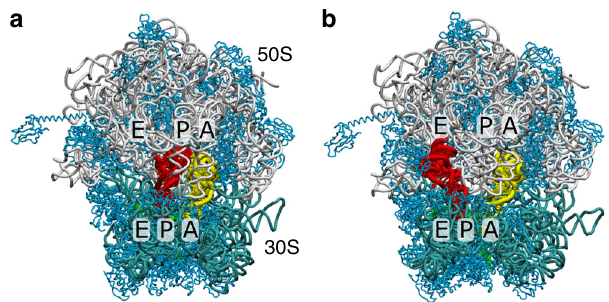
Fig. 1 P/E hybrid formation on the ribosome. a In the pre-translocation state, tRNA molecules adopt classical A/A and P/P con fi gurations 63 , where one tRNA binds the A sites of the small (30S) and large (50S) subunits, while a second tRNA binds the P sites. The 23S, 16S, mRNA, and proteins are shown in gray, cyan, green, and light blue. b In order for the mRNA and tRNA to be displaced between binding sites (i.e. translocation) the P-site tRNA must fi rst adopt a “ hybrid ” P/E con fi guration, where it bridges the P site of the small subunit and E site of the large subunit. In addition, the body of the small subunit undergoes a rotation of ~7°. Structural model of a so- called TI Pre con fi guration is shown (see Supplementary Note 1 for